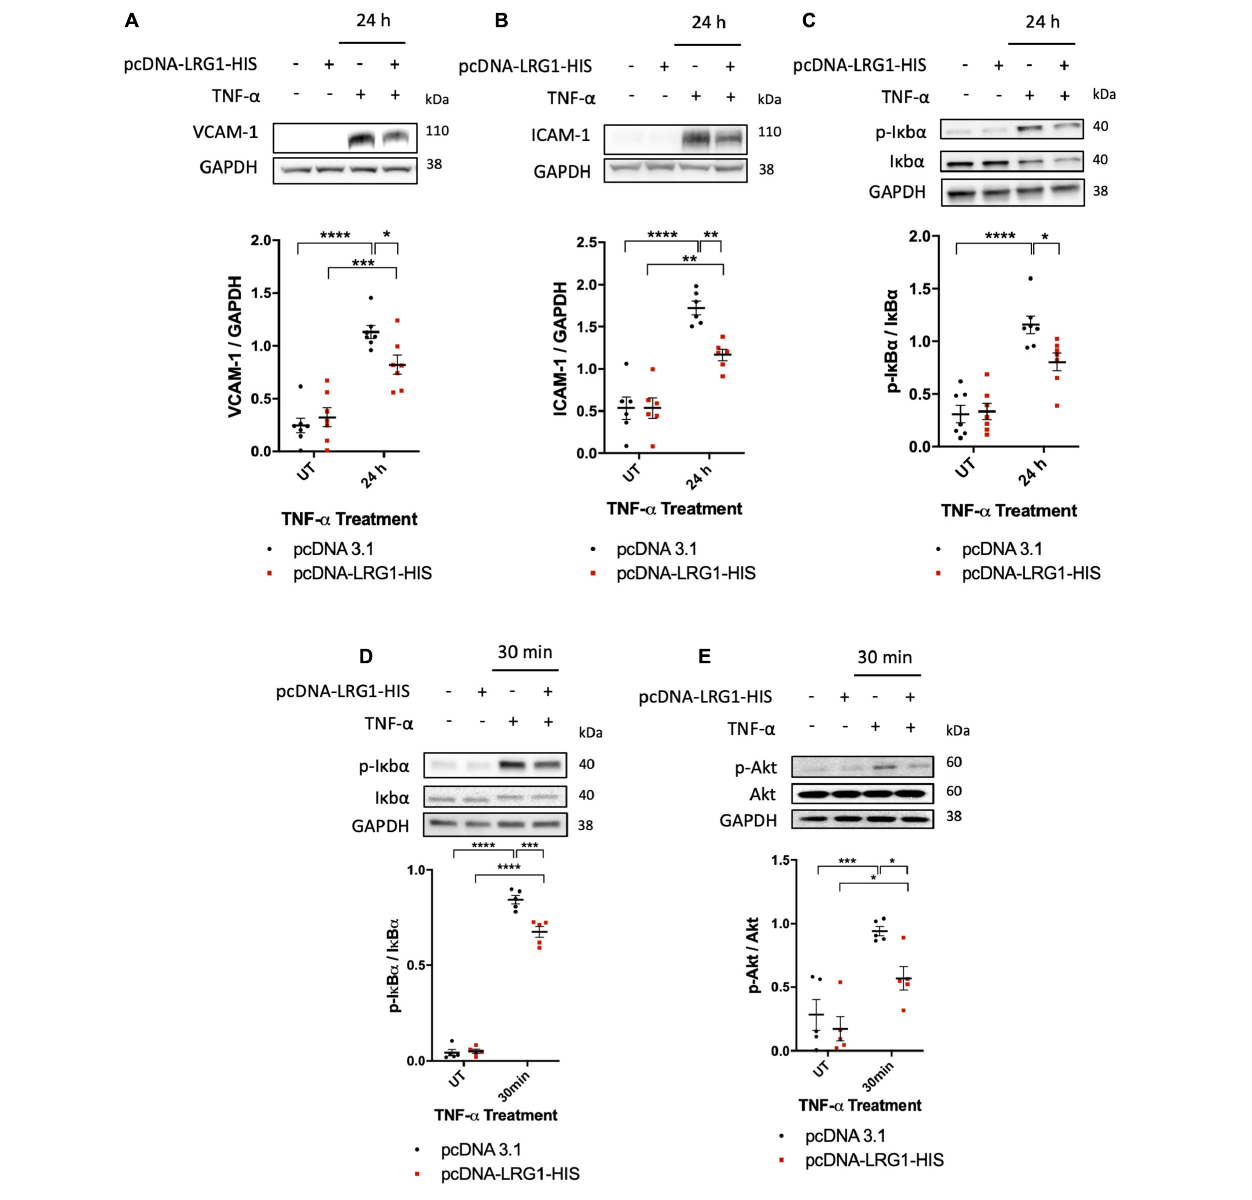
FIGURE 4 | Leucine-rich α -2-glycoprotein (LRG1) overexpression suppressed activation by TNF- α . Representative blots and graphs of quantified (A) VCAM-1, (B) ICAM-1, and (C) I κ B α in transfected cells. LRG1 overexpression in HUVECs suppressed VCAM-1, ICAM-1, and I κ B α phosphorylation 24 h after TNF- α administration and suppressed (D) I κ B α and (E) Akt phosphorylation 30 min after TNF- α administration, compared to HUVECs transfected with control plasmid. (One-way ANOVA followed by Bonferroni post hoc test; n ≥ 5. * p < 0.05; ** p < 0.01; *** p < 0.001; **** p <